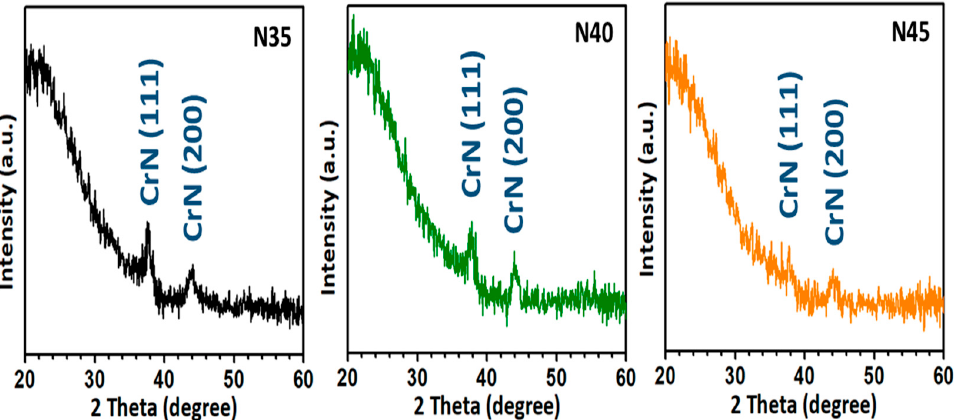
Figure 1. XRD patterns for all CrN films with nitrogen-to-argon ratios varying from 3.5 (N35), to 4.0 (N40), to 4.5 (N45), respectively.